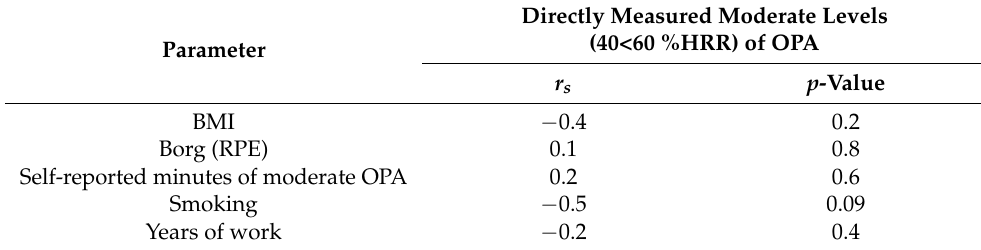
Table 6. Spearman correlation coefficients and p -values between directly measured moderate levels of OPA and BMI, Borg (RPE), self-reported minutes of moderate levels of OPA, smoking, and years of work.